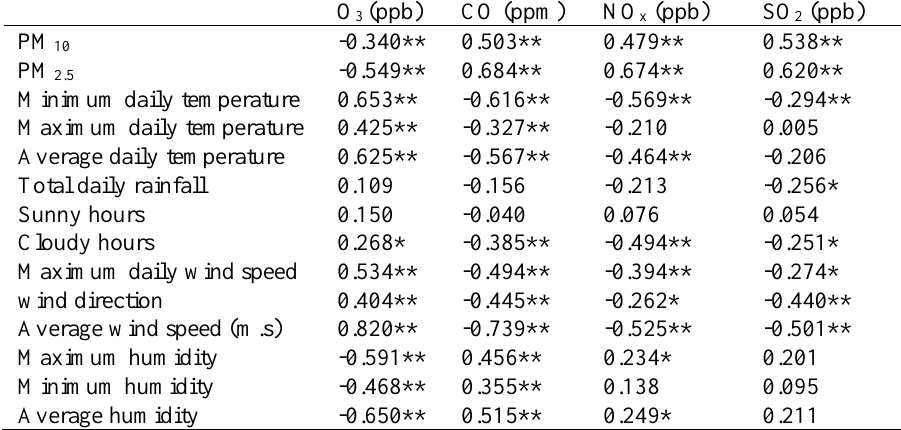
Table 2. Pearson's